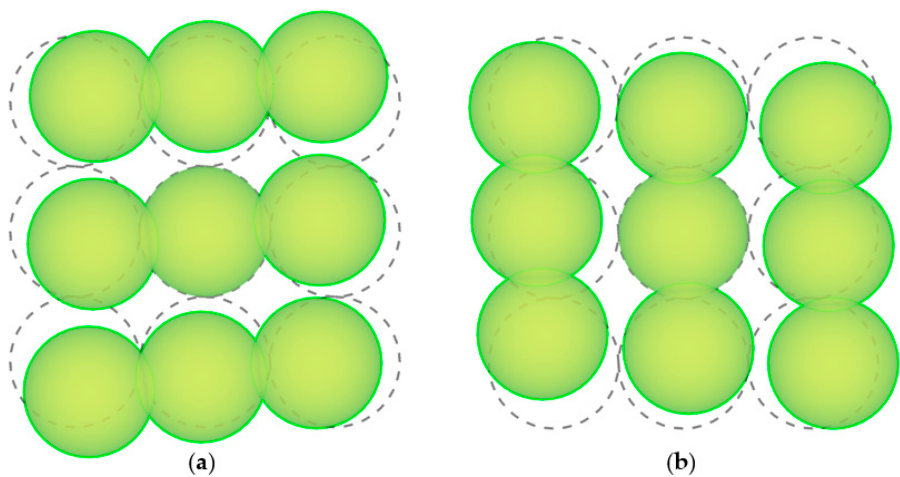
Figure 17. The packing structure of grains at the time to ( a ) peak and ( b ) trough displacement in the steady wave field.